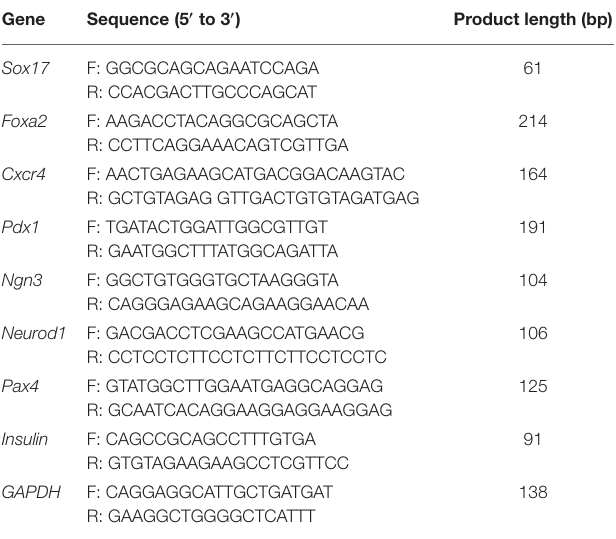
10% (v/v) FBS. Nonadherent cells were removed 48 h after initial plating by intensely washing the flasks.